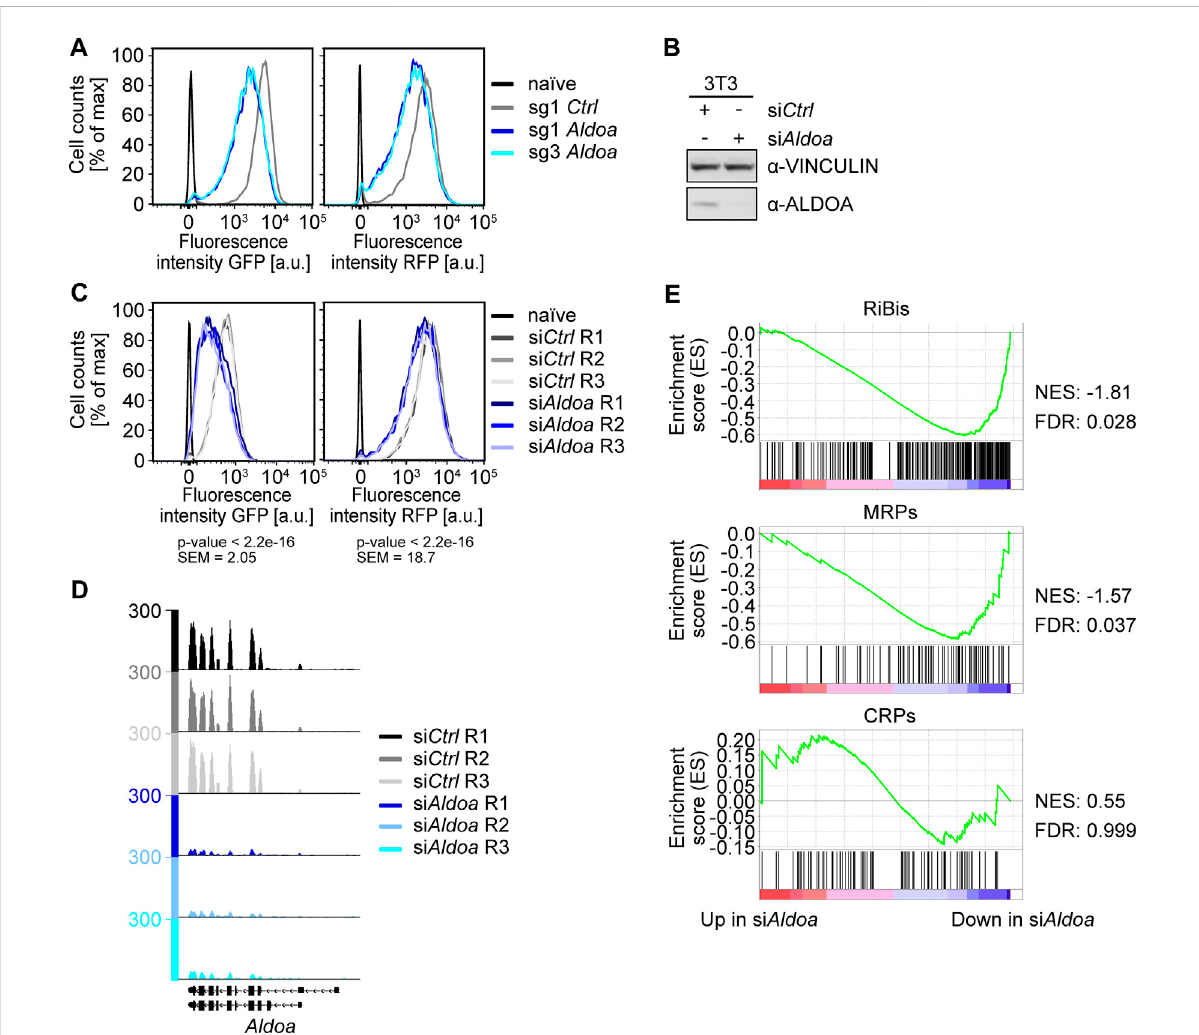
FIGURE 4 Analysis of the role of ALDOA in ribosome biogenesis. (A) FACS analysis of Fbl -promoter-driven EGFP-PEST (GFP) and Rpl18 -promoter-driven tRFP-PEST (RFP) upon Aldoa knockout. FACSanalysis ofthescreening cell line3T3 Fbl − GFP; Rpl18 − RFP sixdays after infection withsgRNAs targeting Aldoa . sg1Ctrl=non-targetingcontrol,naïve=wildtypeNIH/3T3cells.Arepresentativeexperimentfromquadruplicateexperimentsisshown. (B) Western blot of ALDOA upon si Aldoa treatment. Cells were harvested 2 days after transfection of a pool of four siRNAs targeting Aldoa in NIH/3T3 cells. VINCULIN was used as a loading control. (C) FACS analysis of Fbl -promoter-driven EGFP-PEST (GFP) and Rpl18 -promoter-driven tRFP-PEST (RFP) upon Aldoa knockdown. R1, R2, and R3 represent the different replicates. FACS analysis was performed three days after siRNA transfection. Mean fl uorescence values (scale values) of the FITC-A channel for cells treated with si Ctrl or si Aldoa (triplicates were pooled for the analysis) were comparedusingatwo-sided,unpairedStudent t -test.Naïve=wildtypeNIH/3T3cells,SEM=standarderrorofthemean. (D) Browsertrackpictureof normalized Aldoa read counts. Cells were harvested 2 days after transfection of a pool of four siRNAs targeting Aldoa in NIH/3T3 cells. (E) Gene set enrichment analysis (GSEA) of ribosome biogenesis genes and ribosomal protein genes upon Aldoa knockdown. Genes were ranked by log10 ( p -value) with the sign indicating the direction of the fold change (a negative fold change indicating downregulation upon Aldoa knockdown). The gene sets analyzed were downloaded from the MSigDB database: “ GOBP_RIBOSOME_BIOGENESIS.v7.5.1 ” , “ GOCC_ORGANELLAR_RIBOSOME.v7.5.1 ” , and “ GOCC_CYTOSOLIC_RIBOSOME.v7.5.1 ” . RiBis = ribosome biogenesis genes, MRPs = mitochondrial ribosomal protein genes, CRPs = cytosolic ribosomal protein genes, NES = normalized enrichment score, FDR = false discovery